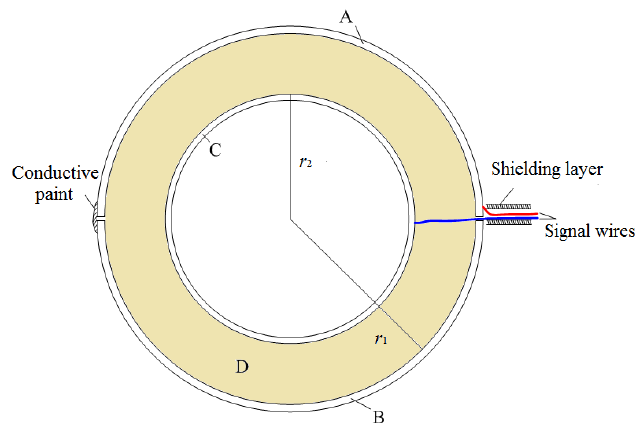
Figure 2. Structure of the double spherical shell sensor.